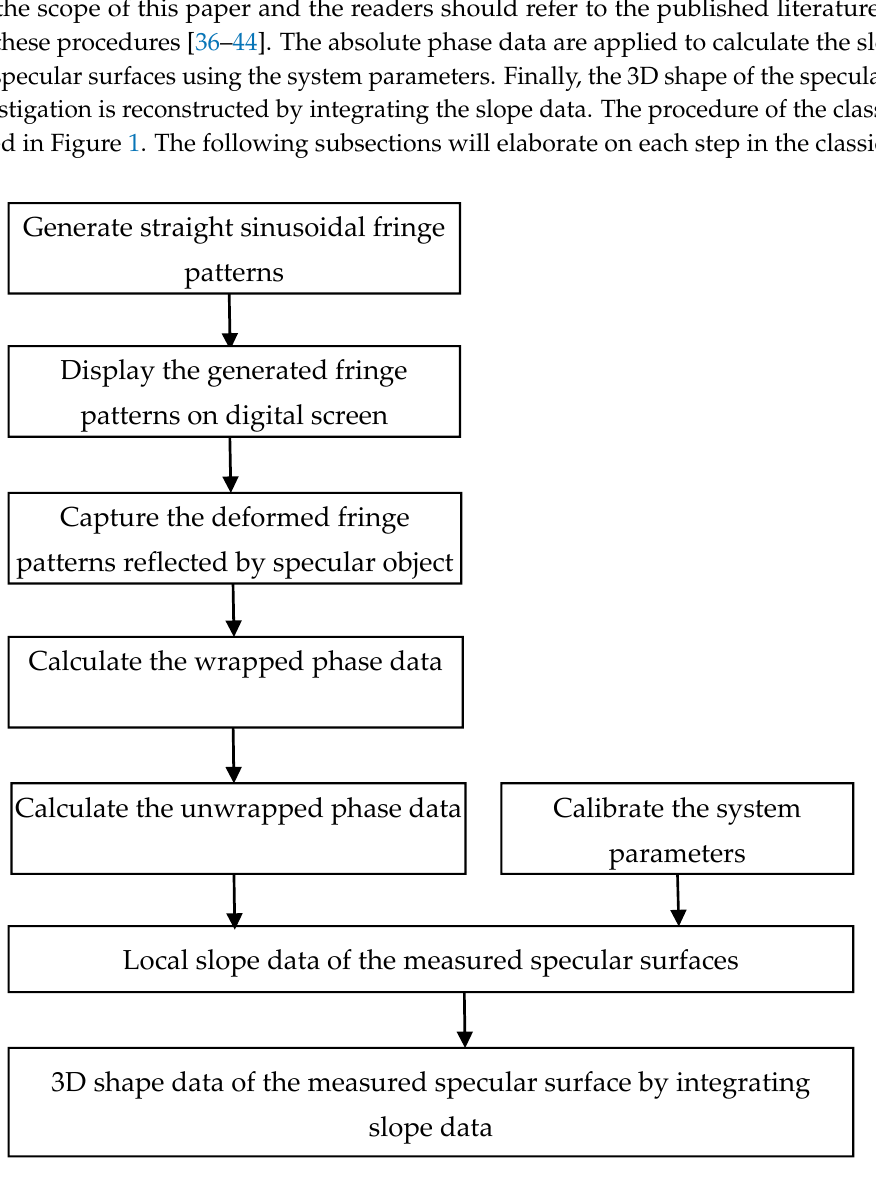
Figure 1. Flowchart of 3D shape measurement of specular objects by using classical PMD.